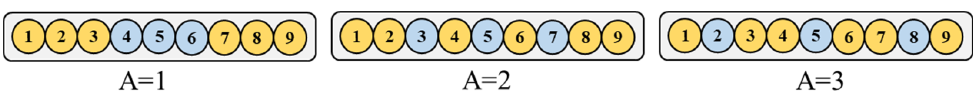
Figure 5. Visual representation of 1D convolution with numerous atrous rates.